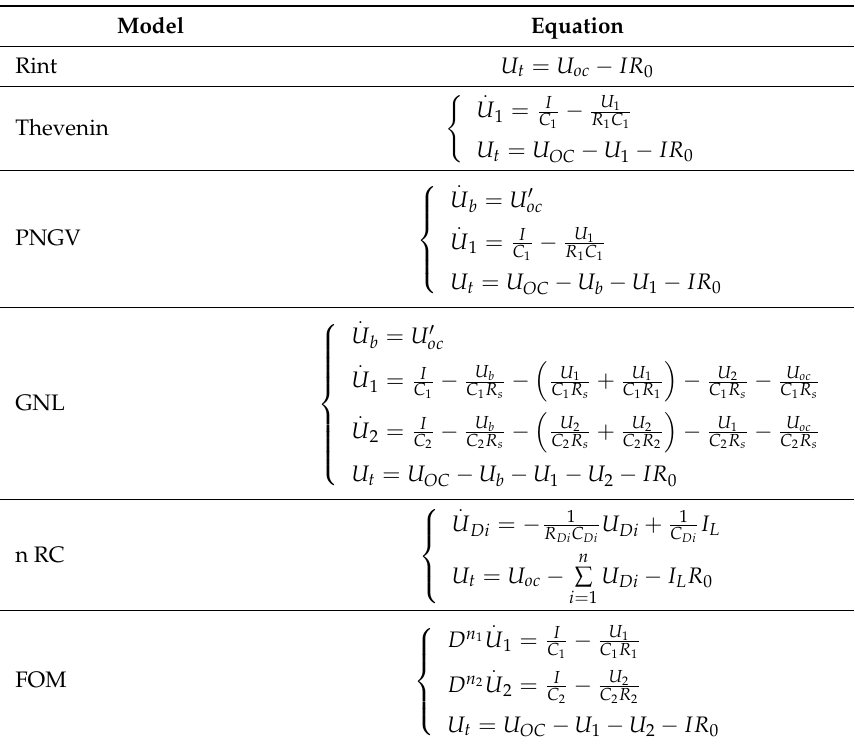
Table 13. Battery ECM models and